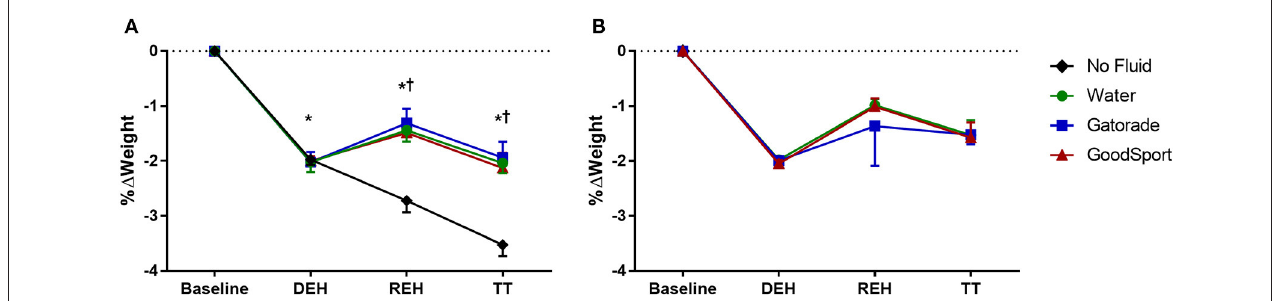
FIGURE 2 | Percent change in body mass during (A) hot dry experiments and (B) thermoneutral experiments. Body mass was lower in all four trials at DEH compared to BASE in the hot-dry condition, and this persisted for the remainder of the study. Body mass was lower in NF compared to the other three conditions at REH and TT. * p < 0.05 compared to BASE. † p < 0.05 compared to no fluid.